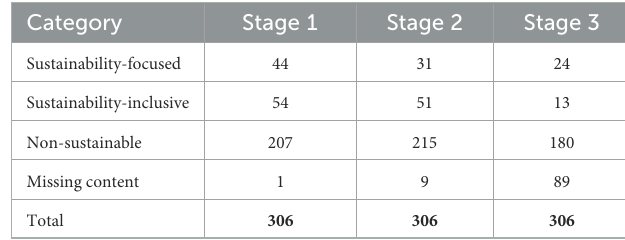
TABLE 2 Manual categorization of the 306 randomly selected TU Dublin modules/courses across the three review